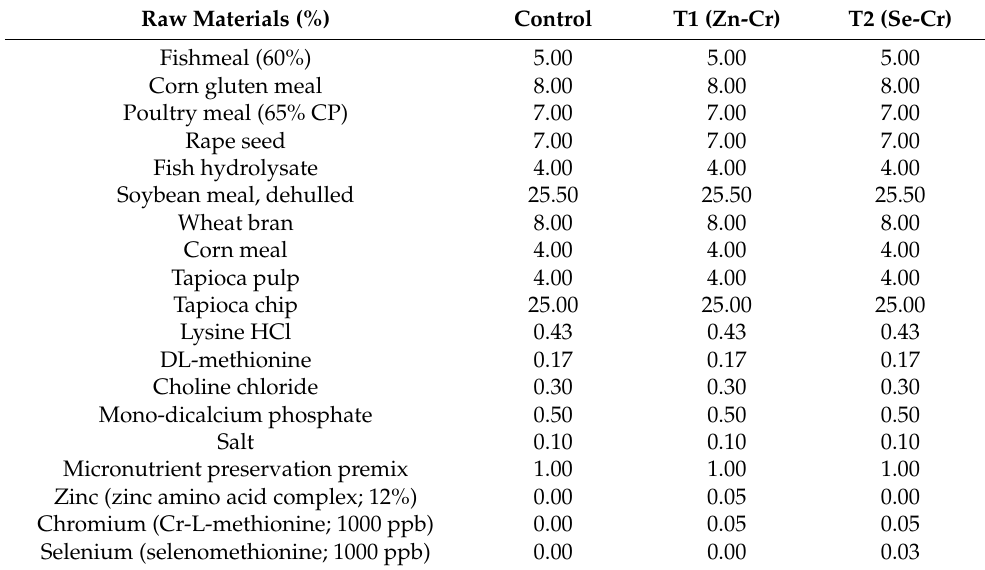
Table 1. The formulations of red tilapia